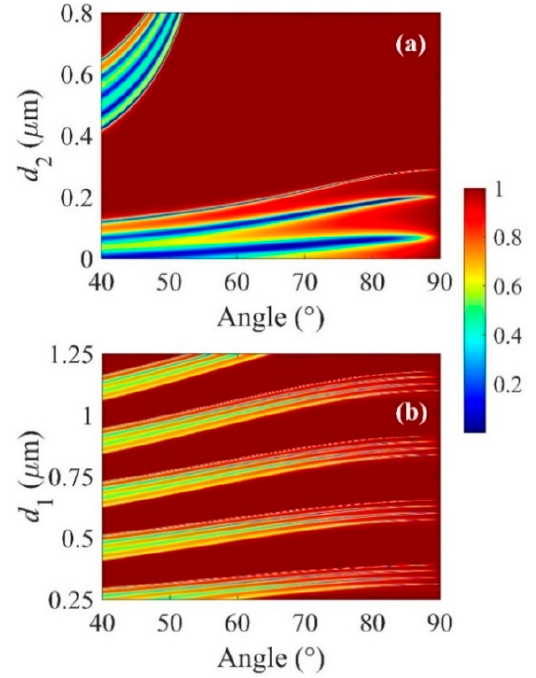
Figure 7. Contour map of reflection spectra as a function of ( a ) d 2 and ( b ) d 1 .